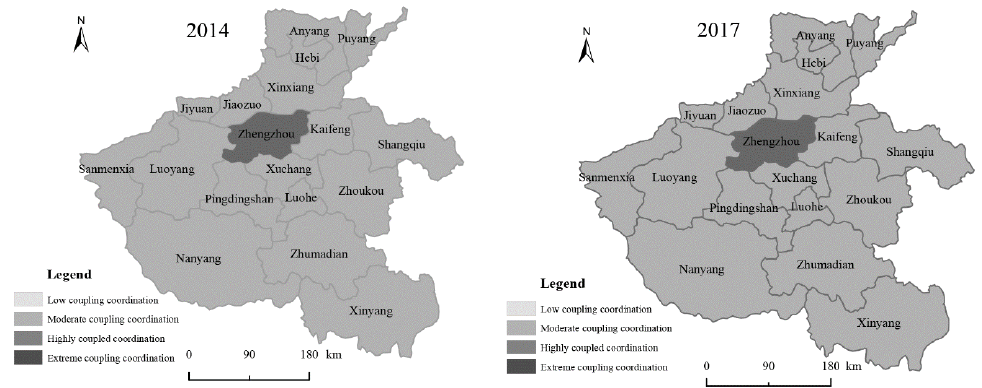
Figure 4. Spatial pattern evolution of the coupling degree of infrastructure construction and economic development in 18 cities in Henan